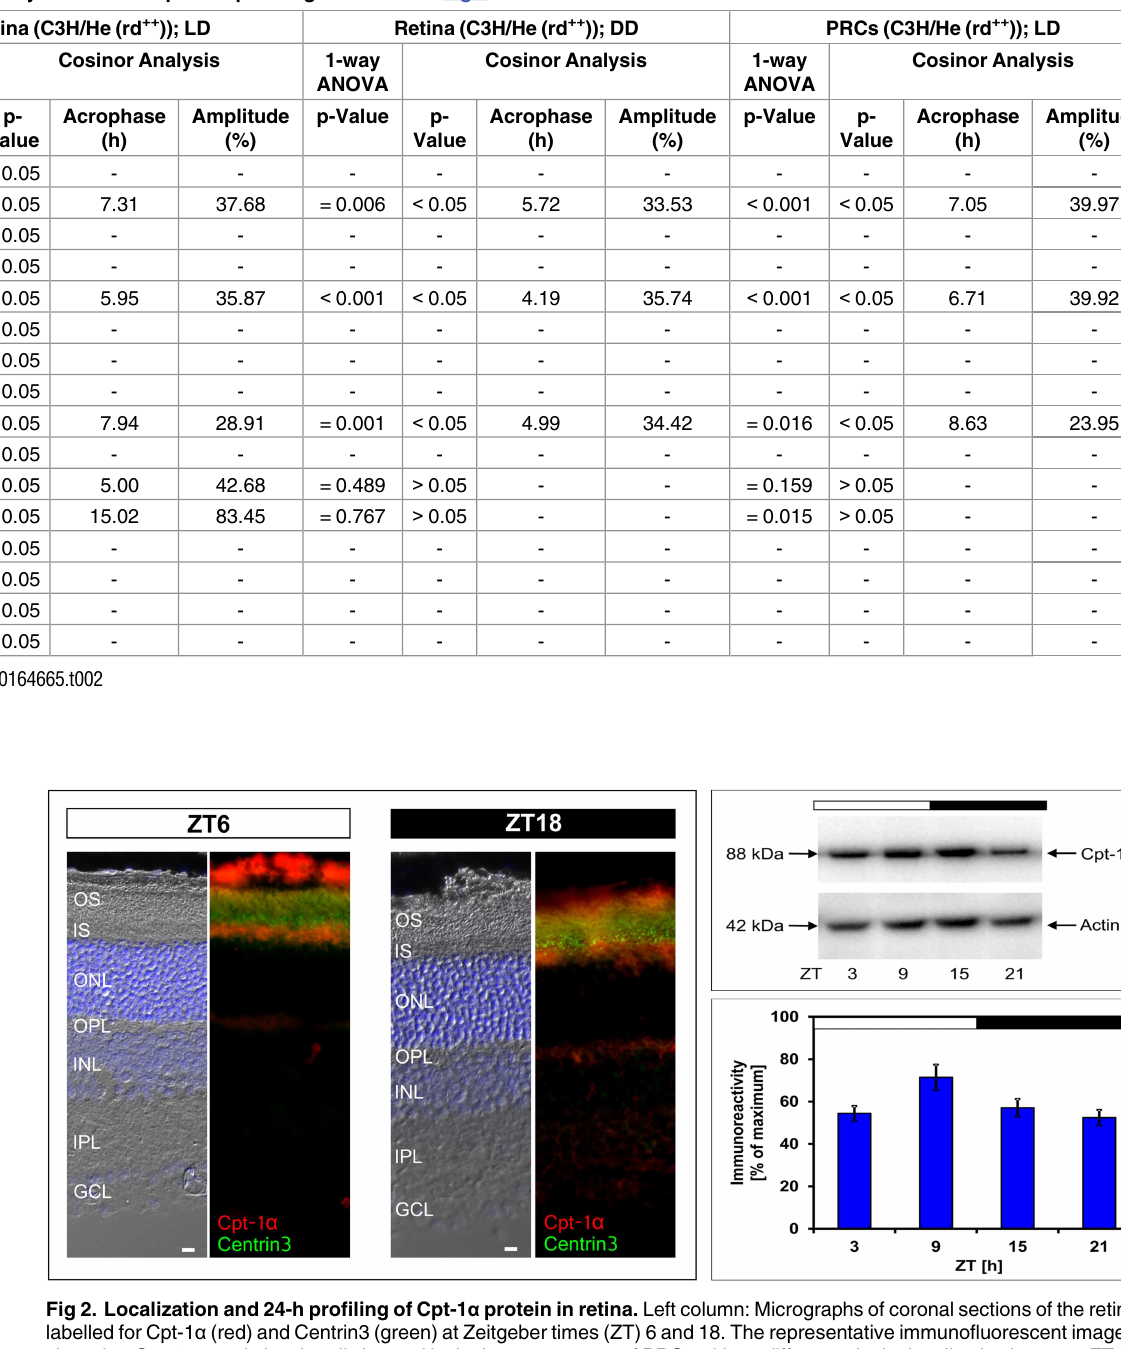
Table 2. Statistical analysis of transcriptional profiling illustrated in Fig 1.